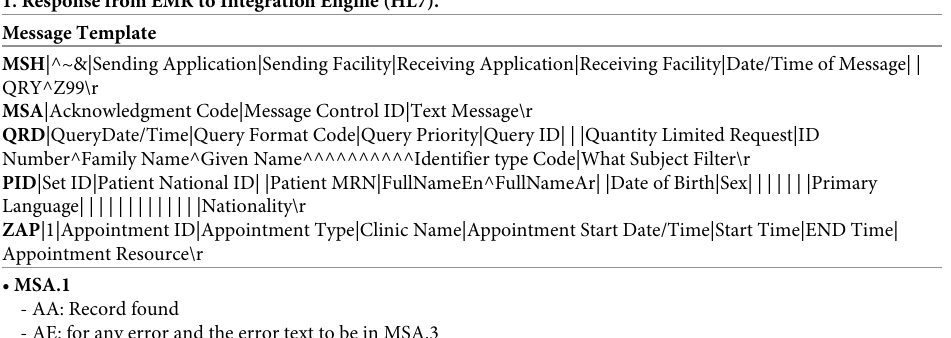
Table 2. Second step to response with details of patient and